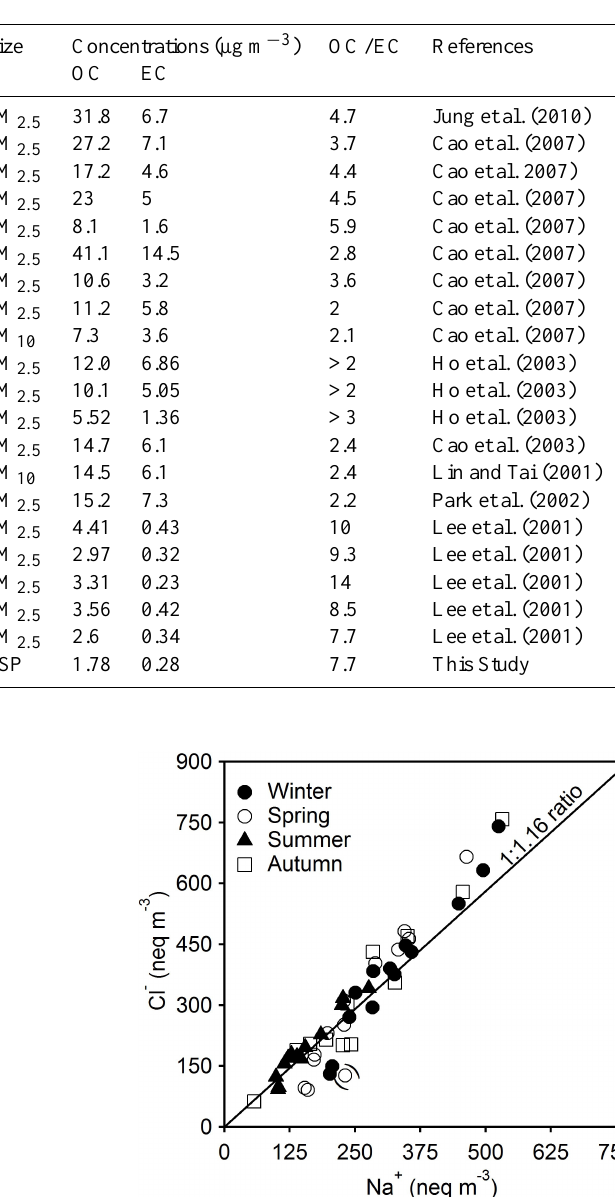
The relative abundances of NO −